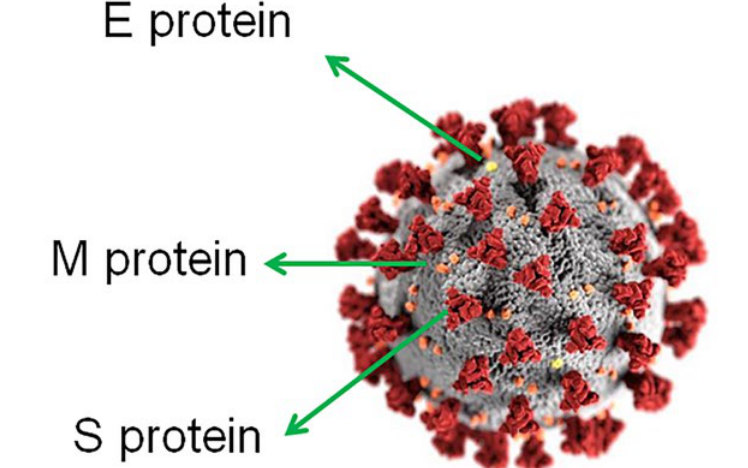
E protein, small envelope (E) protein; M protein, matrix (M) protein; S protein, spike (S) glycoprotein (homotrimer). Adapted from “Centers for Disease Control and Prevention (CDC)/ Alissa Eckert, MS; Dan Higgins,